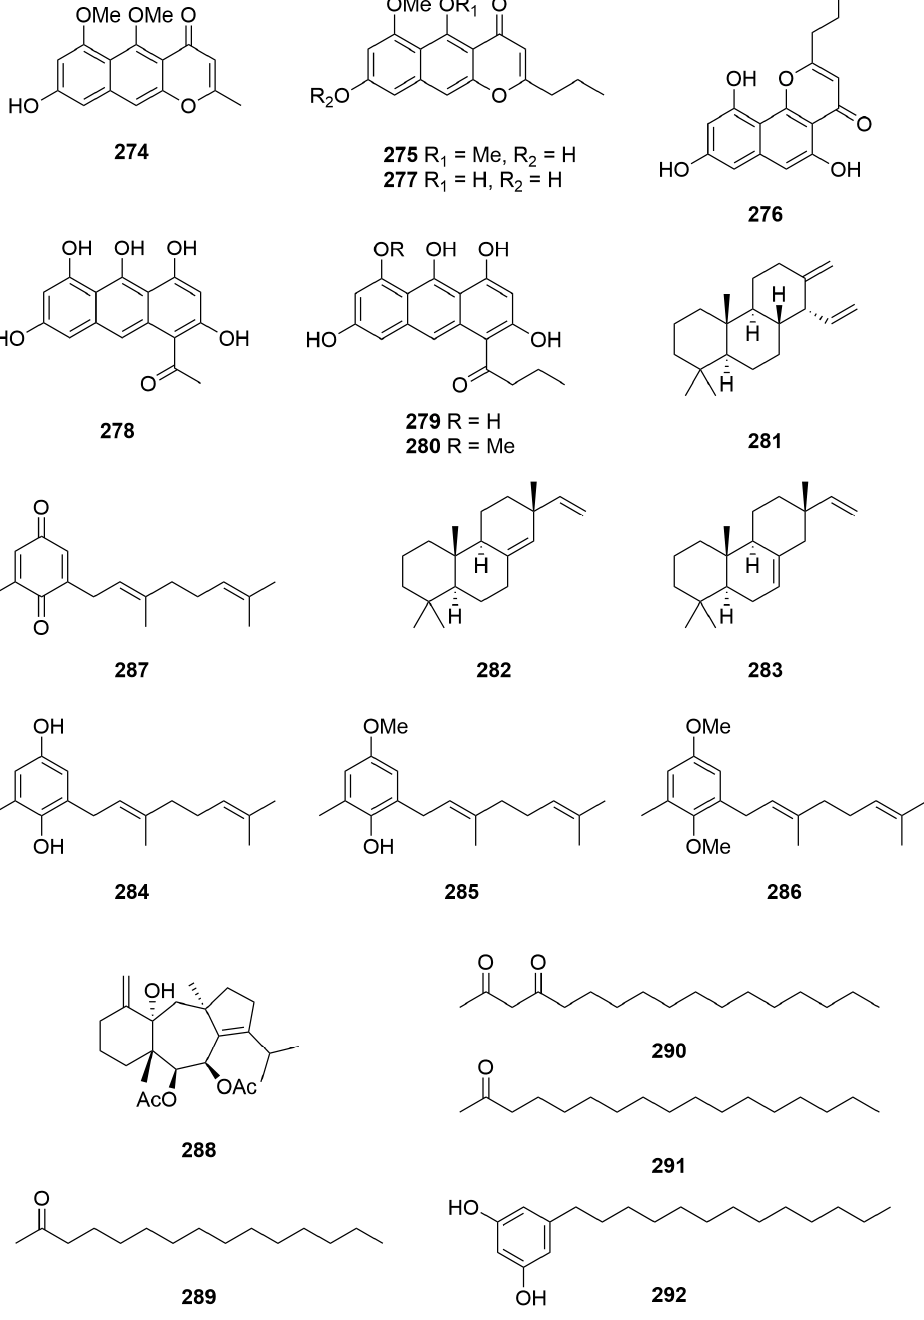
Figure 18. Compounds 274 to 292 .